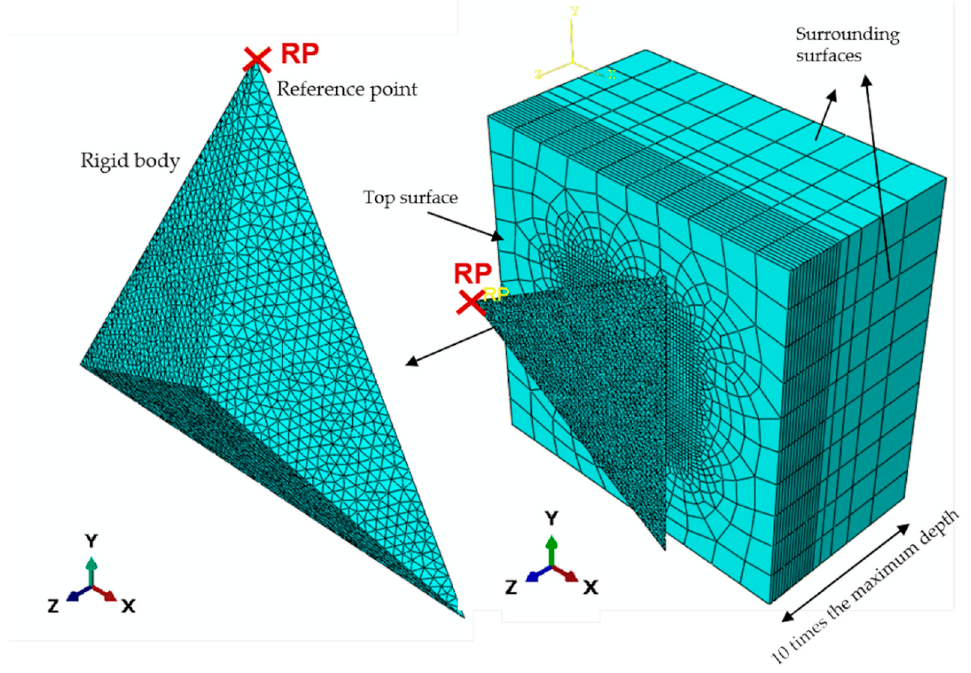
Figure 3. 3D model and meshing arrangement for one indent.